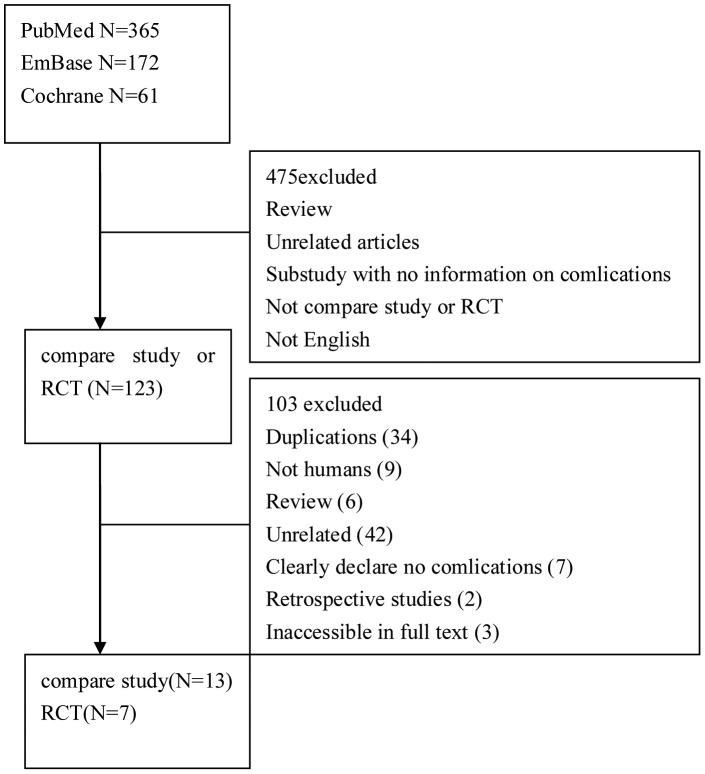
Study flow diagram.